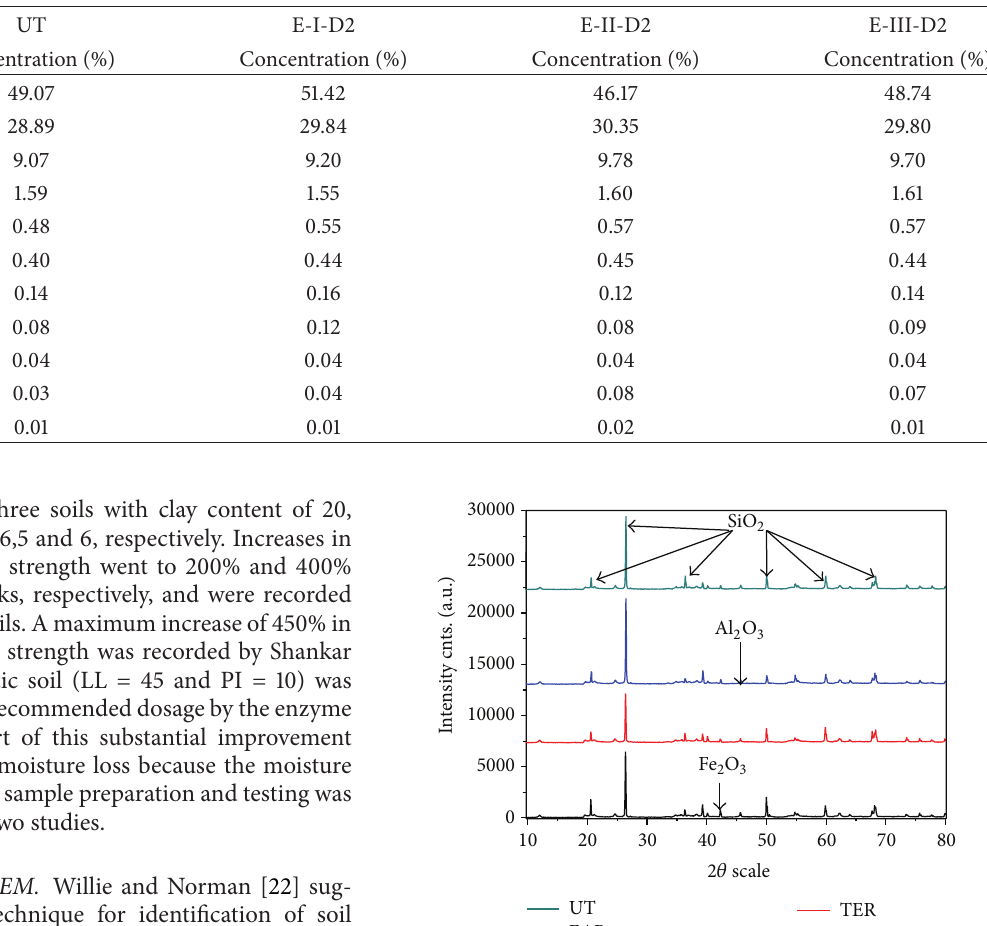
Table 5: Comparison of XRF results for untreated (UT) soil samples and soils treated with three enzymes.